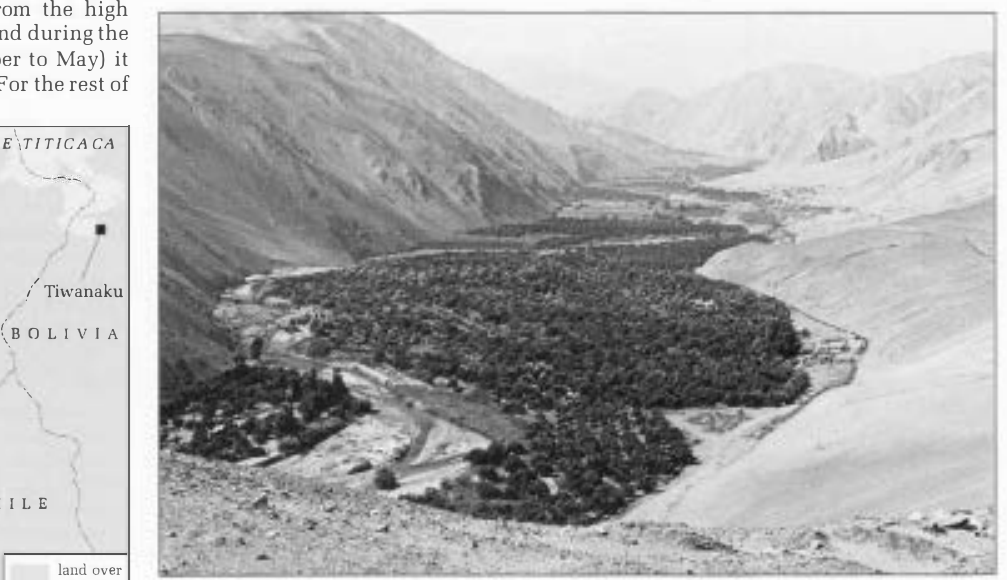
Figure 3 The Ilo valley, looking towards the highlands from the site of Chiribaya Alta. Down in the valley, the nearest farm on the right is Chiribaya, and beyond it in the Figure 1 Location of Ilo and the Ilo distance is the vWage of El (Osmore) valley in southern Peru.